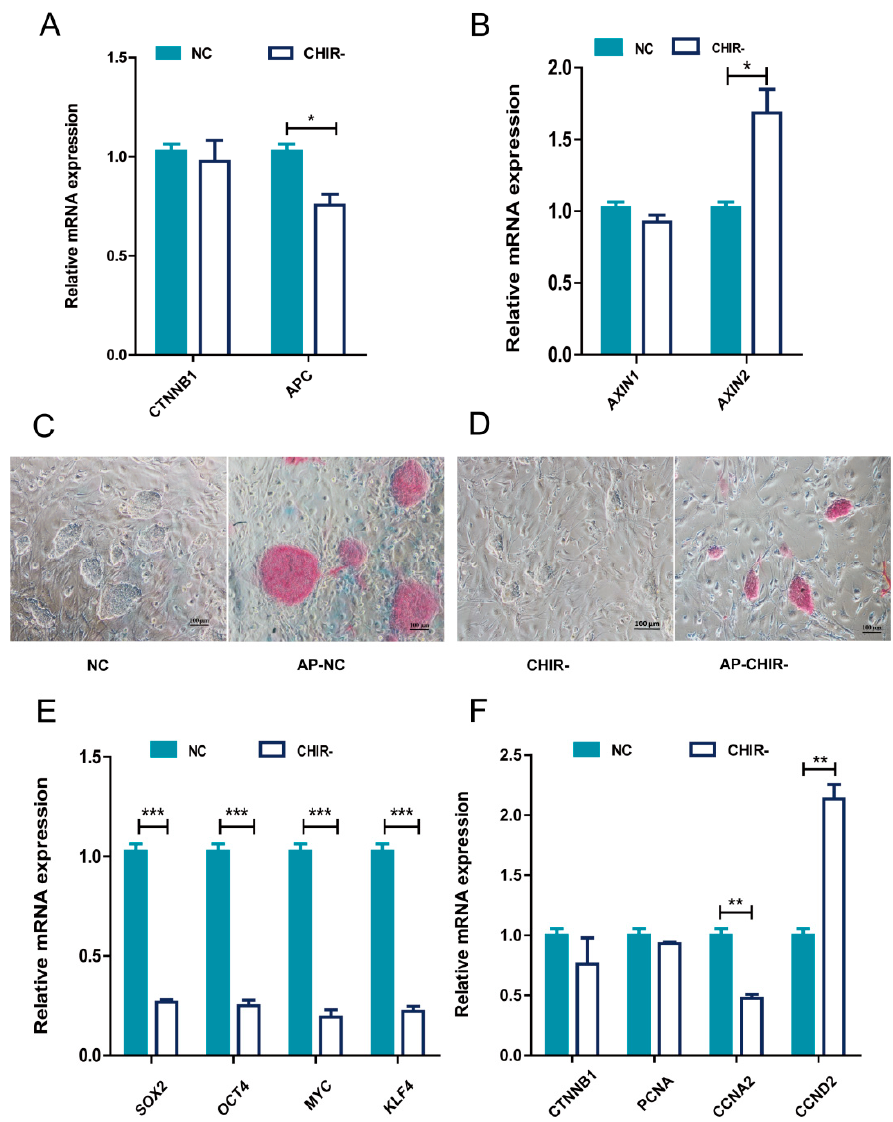
Figure 1. CHIR99021 is crucial to maintain the pluripotency and proliferation of piPSCs. ( A )qPCR analysis of the expression levels of CTNNB1 and APC in the NC and CHIR- groups, ( B ) qPCR analysis of the expression levels of AXIN1 and AXIN2 in the NC and CHIR- groups, ( C , D ) Representative image of colonies and AP staining after 5 days of clonal growth of piPSCs in the control (NC) and removal of CHIR99021 (CHIR-) conditions, ( E ) qPCR analysis of the expression levels of endogenous OCT4 , SOX2 , KLF4 , and MYC in the NC and CHIR- groups ( F ) qPCR analysis of the expression levels of CCND1 , CCND2 , PCNA , and CCNA2 in NC and CHIR- groups; * represents p < 0.05, ** represents p < 0.001, and *** represents p < 0.0001.